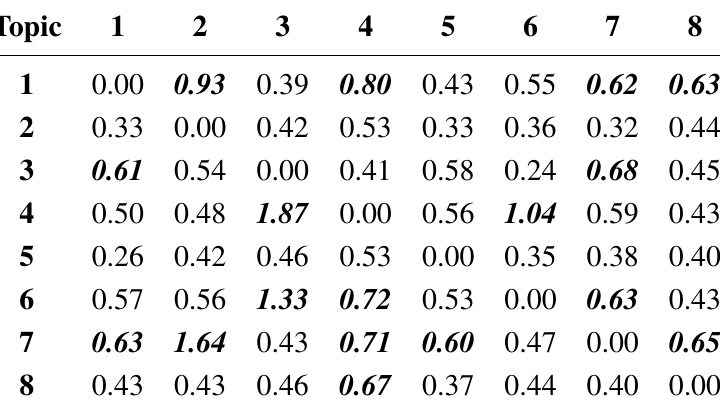
Table 1. Causal matrix for the intersection